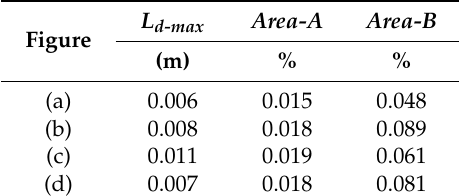
Figure 10. Evaluation chart.